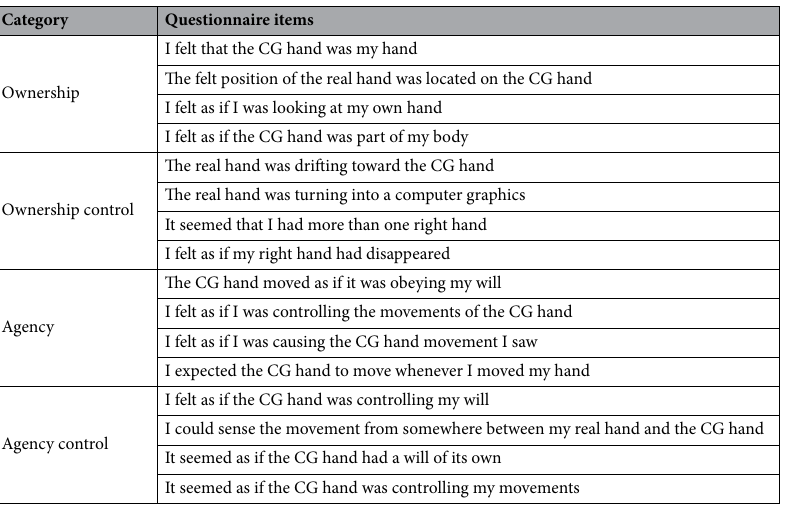
Table 2. Questionnaire items for measuring subjective aspects of the computer graphics (CG) hand in experiment 2. Participants rated their level of agreement with each item on a 7-point scale, ranging from -3 (strongly disagree) to + 3 (strongly agree).